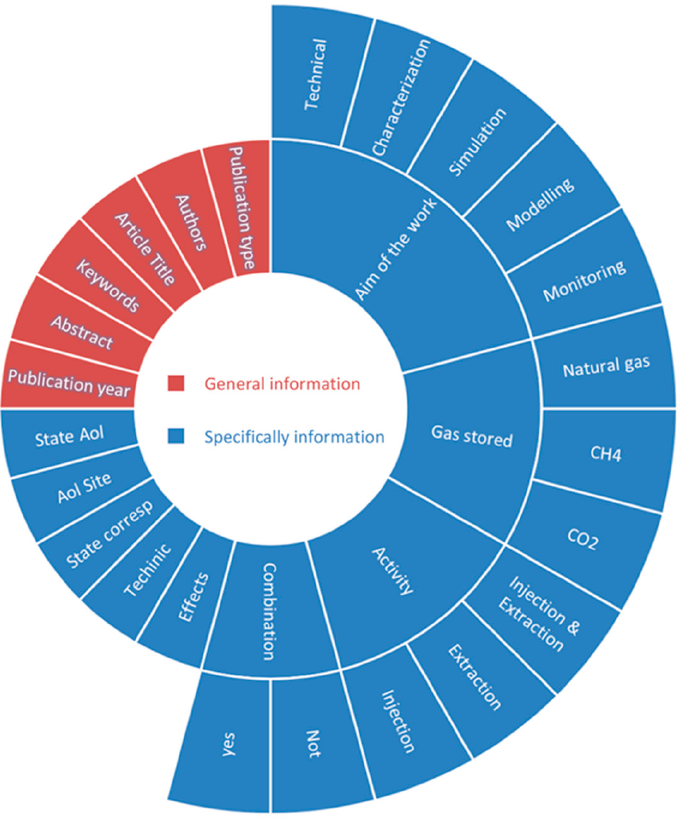
Figure 5. Head of the database used to classify the information of the 60 selected contributions. The general information is represented with the blue color while the detailed information is highlighted in red.